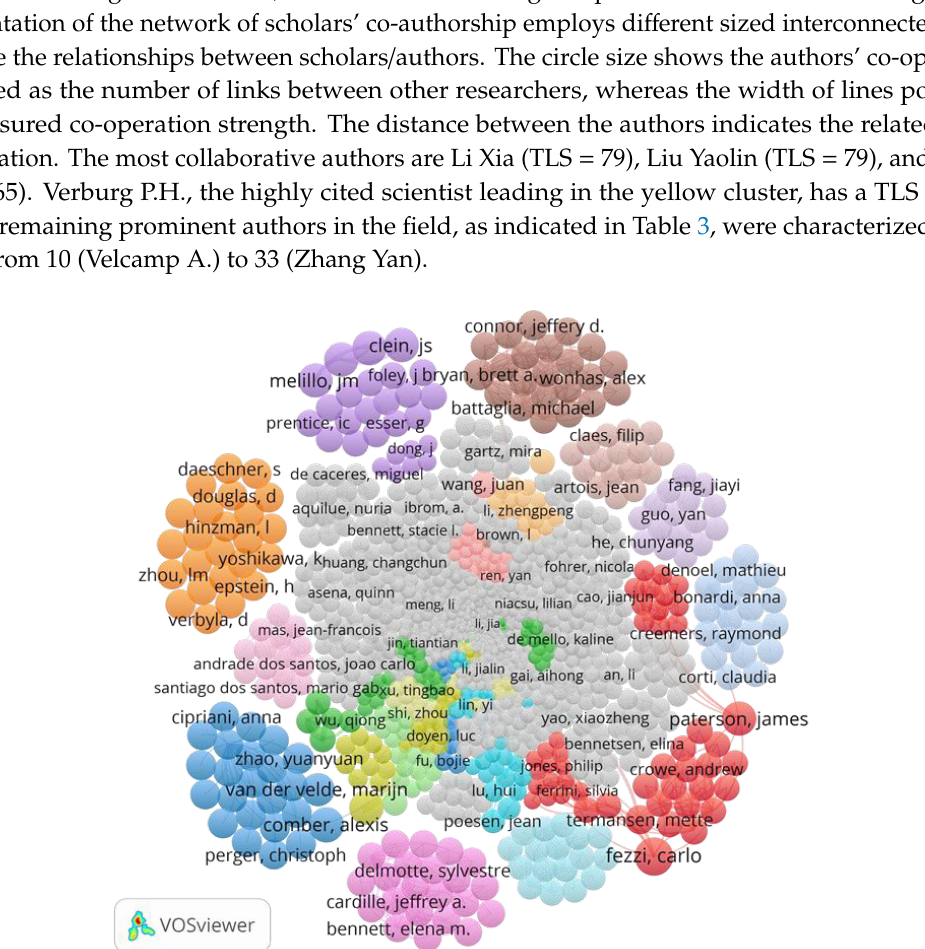
Figure 3. Network of scholars’ co-authorship, lin/log modularity clustering (147 clusters).